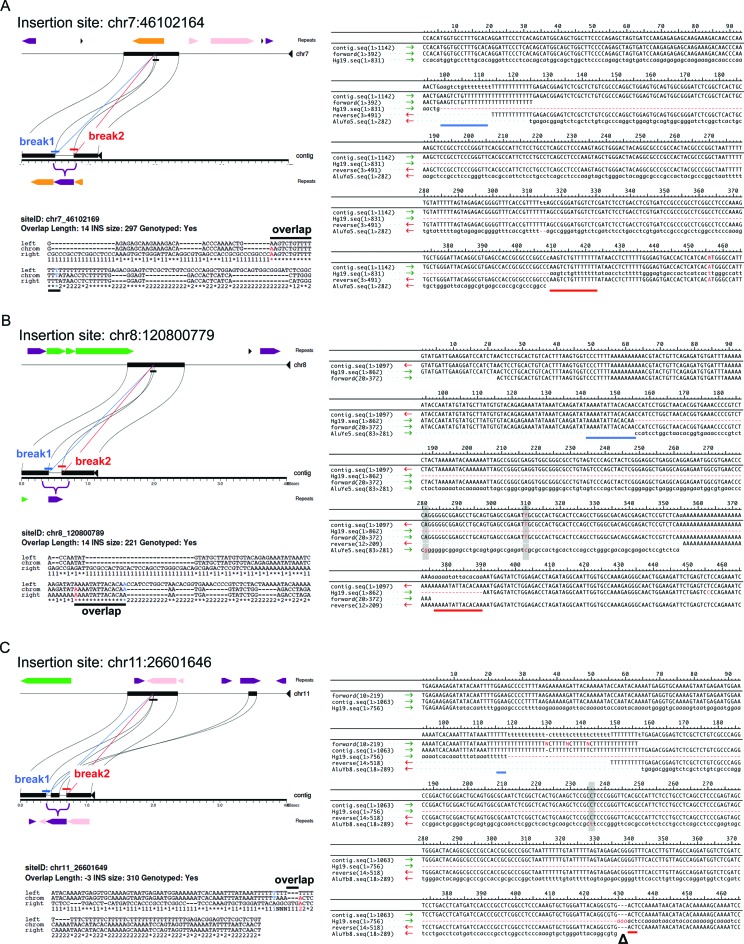
Sequence analysis of assembled non-reference Alu insertions. Breakpoints were determined based on alignment the 5′ and 3′ edge of each insertion sequence with the corresponding sequence from the hg19 reference. Miropeats annotation, aligned breakpoints and Sanger sequences are shown for three representative insertions. (A) Insertion at chr7:46102164 of 297 bp Alu with breakpoint overlap of 14 bp. Upper left: alignment and breakpoint prediction of the assembled contig to hg19. Aligned breaks are shown in blue or red (leftmost or rightmost aligned nucleotides, respectively); the bracket indicates the Alu location in the contig relative to hg19. Repetitive elements in the reference and assembled contig are shaded: LINEs, green; SINEs, purple; LTRs, orange; DNA elements, pink. Lower left: 3-way alignment of Alu-flanking assembled stretches to hg19. A ‘1’ or ‘2’ indicates nucleotides aligned between the assembled contig and hg19 reference upstream or downstream of the Alu junction. A ‘*’ indicates identical positions. Terminal nucleotides of the left and right breaks are shaded as above; the black bar shows contig overlap. Right: Alignment of the assembled contig with Sanger sequence data to the hg19 empty allele and subfamily consensus for that insertion. Blue and red bars indicate left and right breaks; shading shows assembled and validated base changes from the subfamily consensus. (B) Insertion at chr8:120800779 of 221 bp with a 14 bp TSD. (C) Insertion at chr11:26601646 of 310 bp with a target site deletion of 3 bp (‘Δ’ in the alignment). All breakpoint and alignment indications are as described in panel A.